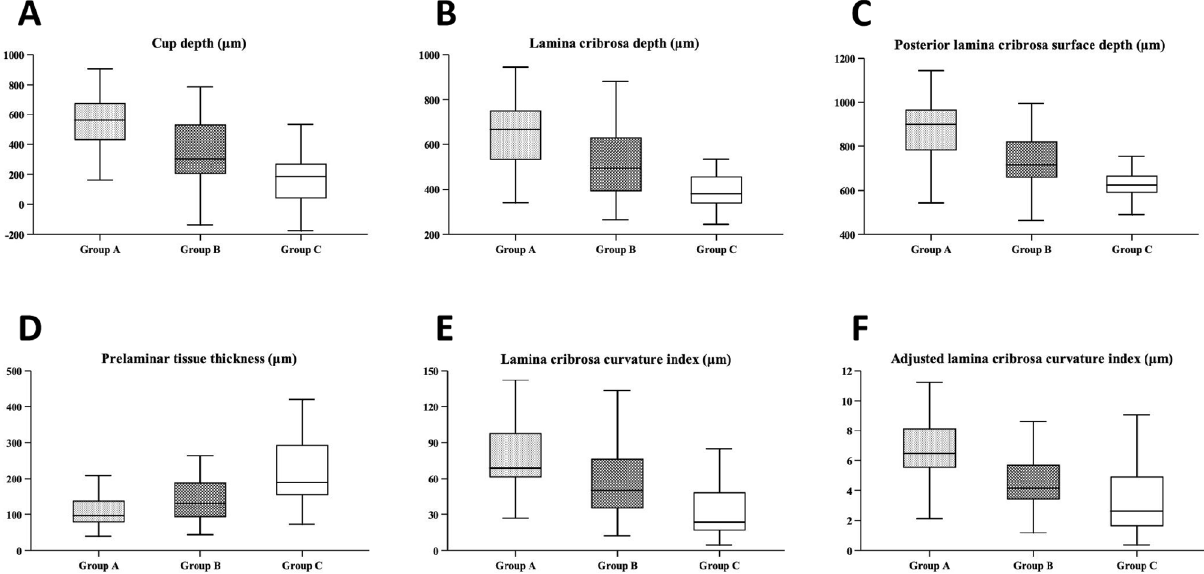
Figure 2. Box diagram of related parameters of lamina cribrosa between three groups ( A – F ) showed the overall distribution of CD, LCD, PLCSD, PTT, LCCI and aLCCI among the three groups, respectively. From the comprehensive depth index ( A – C ), group A (IOP ≥ 30 mmHg) was significantly deeper than Group C (Normal control), and followed by group B (21 mmHg ≤ IOP < 30 mmHg), and the same performance was shown in curvature index ( E , F ). In the PTT ( D ), the performance of the three groups was opposite to that of the anterior index, that is, PTT with group A (IOP ≥ 30 mmHg) was significantly